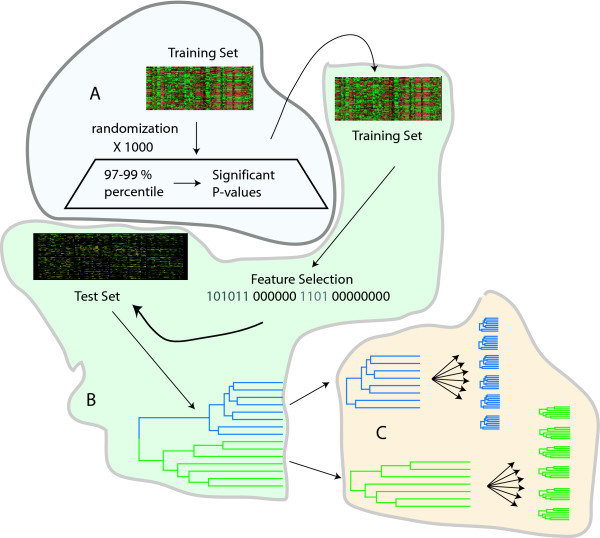
Flowchart of the proposed method. (A) A randomization approach is used to identify homogeneous expression regions of statistically significant length within each gene. (B) Genes that contain such regions are used to discriminate between class categories via hierarchical clustering. (C) Detection of sub-groups within each class is then based on informative gene clustering.